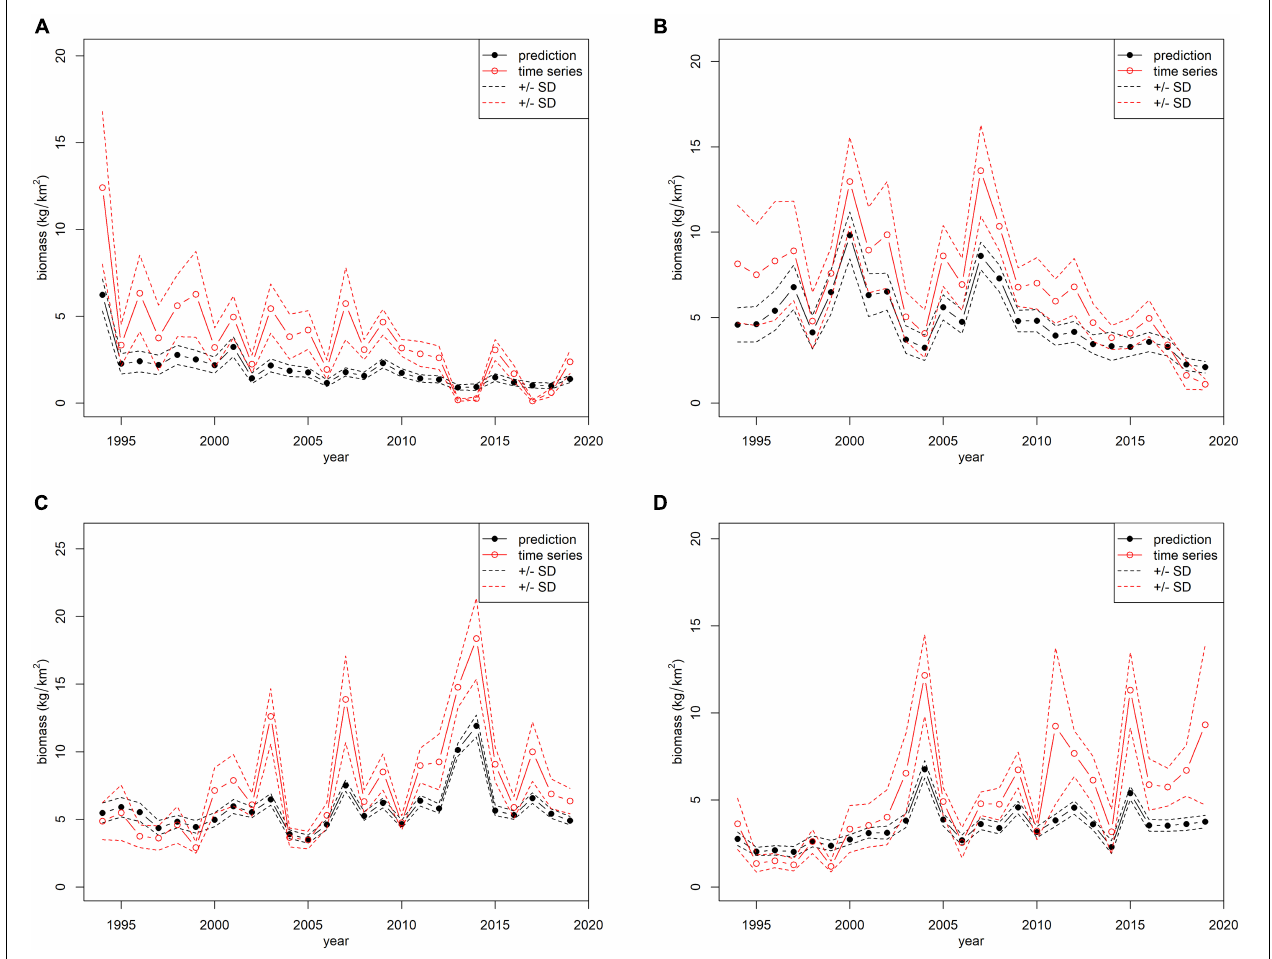
FIGURE 2 | Comparison between the observed (red lines) and standardized (black lines) biomass indices (kg/km 2 ) of the MEDITS survey from the south of Sicily (GSA16): (A) Eledone cirrhosa; (B) Eledone moschata; (C) Illex coindetii; (D) Todaropsis